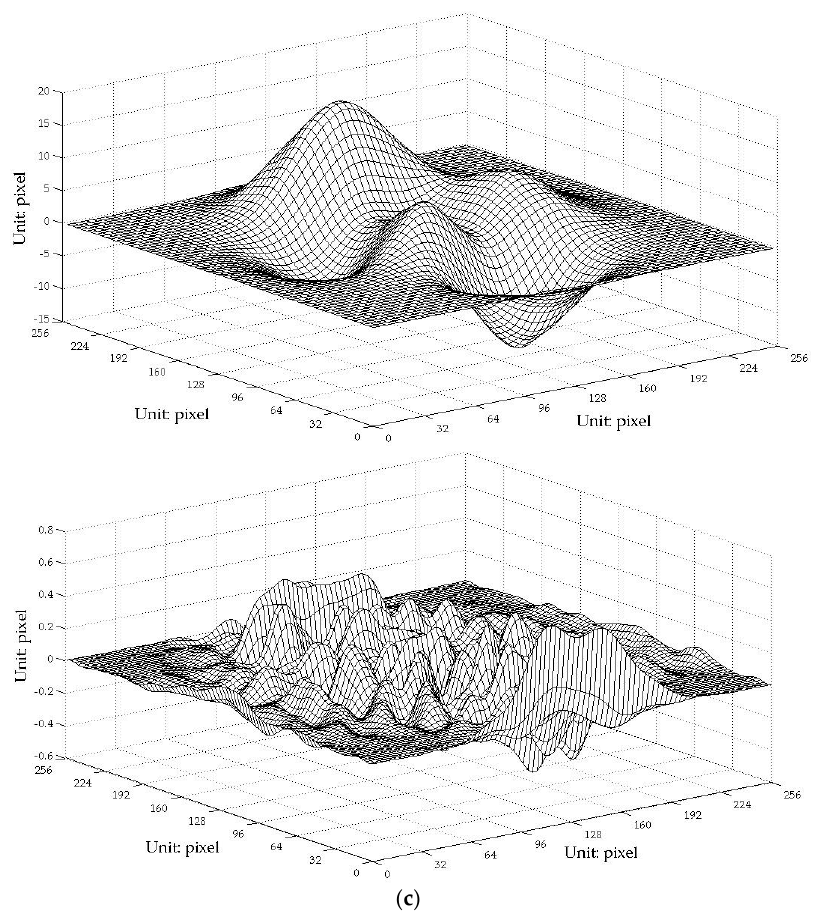
Figure 9. Simulation using the Peaks function. ( a ) The original image; ( b ) the up image shows the rebuilt profile using PMP method and the down image shows the errors between the 3D reconstruction and the original; ( c ) the up image shows the rebuilt profile using the one-shot CP technique and the down image shows the errors between the 3D reconstruction and the original.